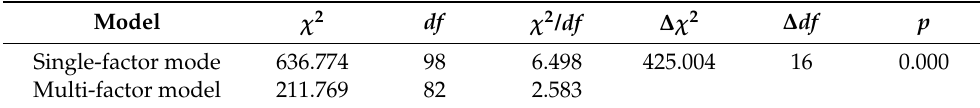
Table 1. Comparison of single-factor and multi-factor